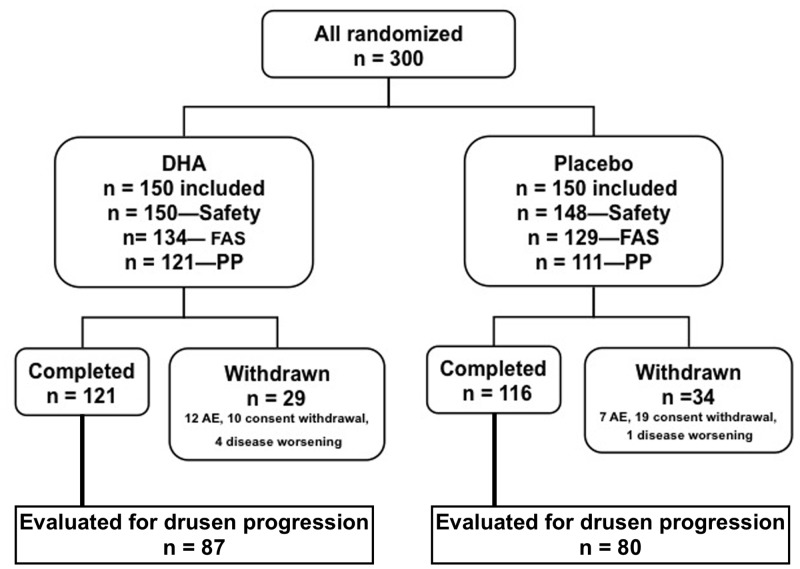
Diagram showing the study population.The safety population included all subjects who have received the study treatment. Full analysis set (FAS) included all subjects in the safety set who have had at least 1 post-baseline evaluation regarding occurrence of choroidal neovascularization. Per protocol (PP) population included all FAS subjects without major protocol deviation. Among those withdrawn there were 3 deaths in the docosahexaenoic acid (DHA) group and 6 deaths in the placebo group.